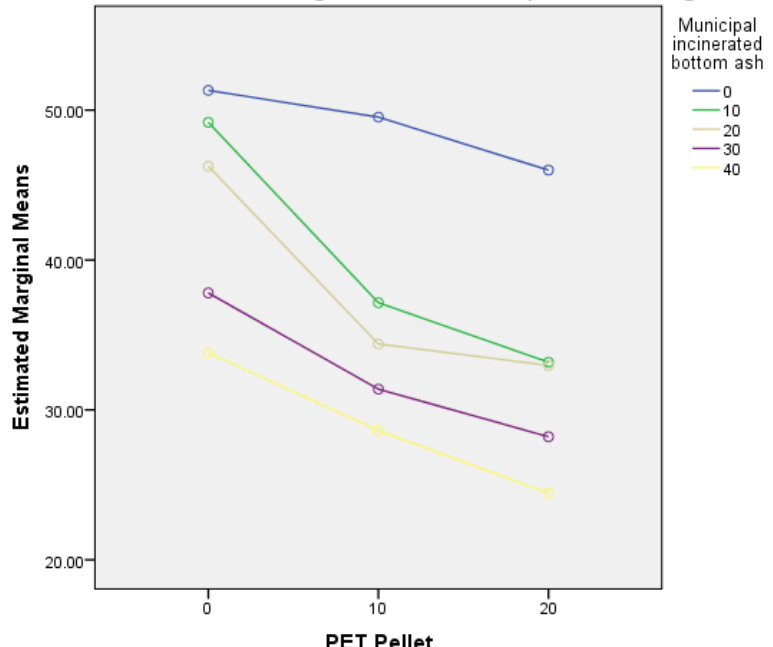
Figure 7. Estimated marginal means of compressive strength between PET pellets and MIBA.